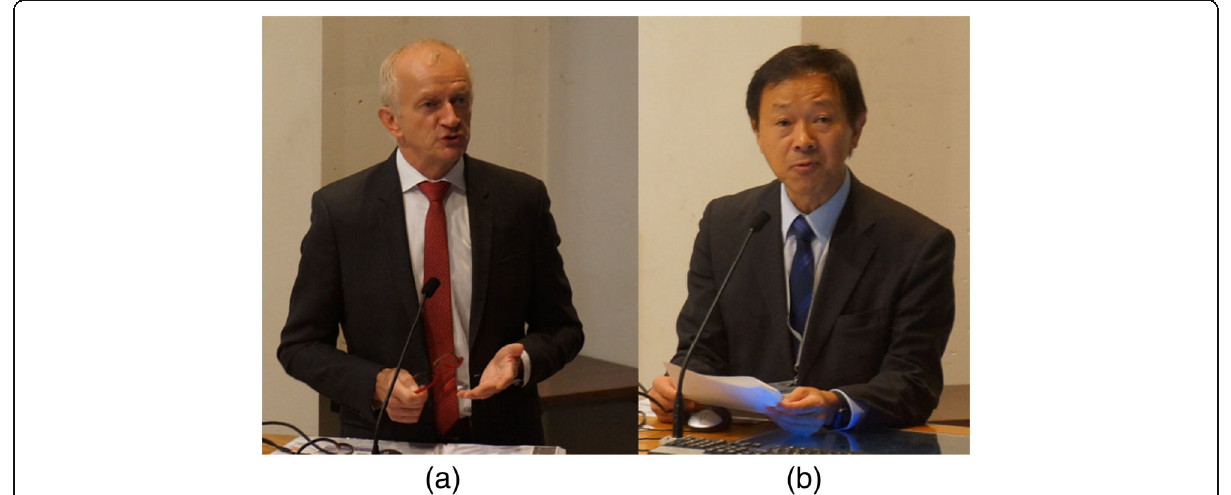
Fig. 2 Opening speech presented by a Prof. Michel Deneken b Prof. Masakatsu